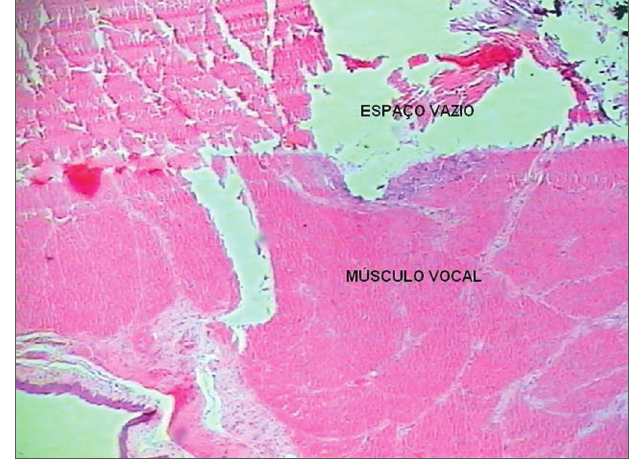
Figura 3. Corte histológico coronal da prega vocal canina direita com sacrifício após 90 dias. Coloração hematoxilina-eosina. Observamos